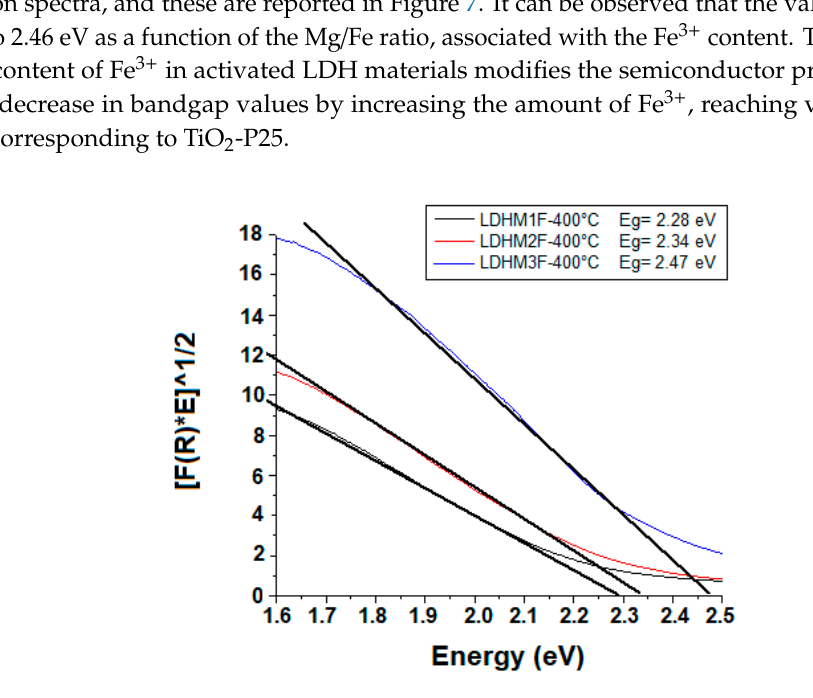
Figure 7. UV-vis-KM (Kubelka–Munk Method) spectra of activated Mg / Fe layered double hydroxides.